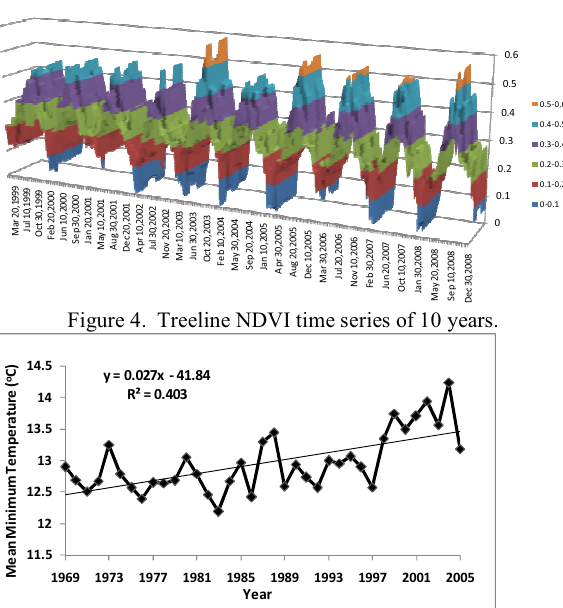
Figure 5. Mean Minimum temperature ( o C) trend in the past decades in Gangotri region. (data Source: National Climate